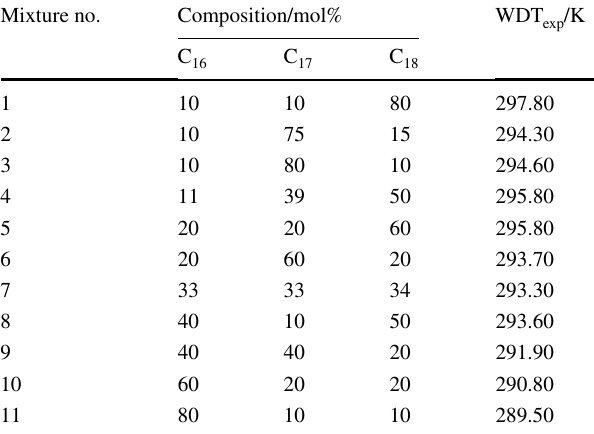
Table 6 Laboratory WDT/K values for system #4 (Metivaud et al. 1999)